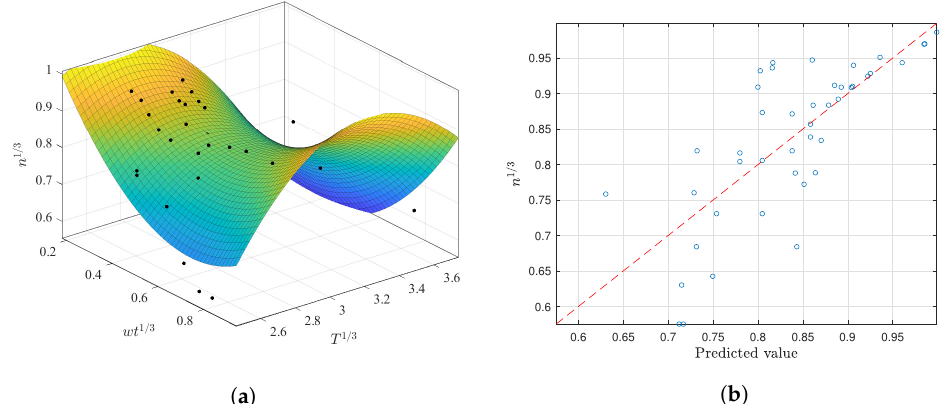
Figure 12. Best polynomial regression of n 13 in terms of wt 13 and T 13 for the XG dataset: ( a ) fitting results and ( b ) prediction